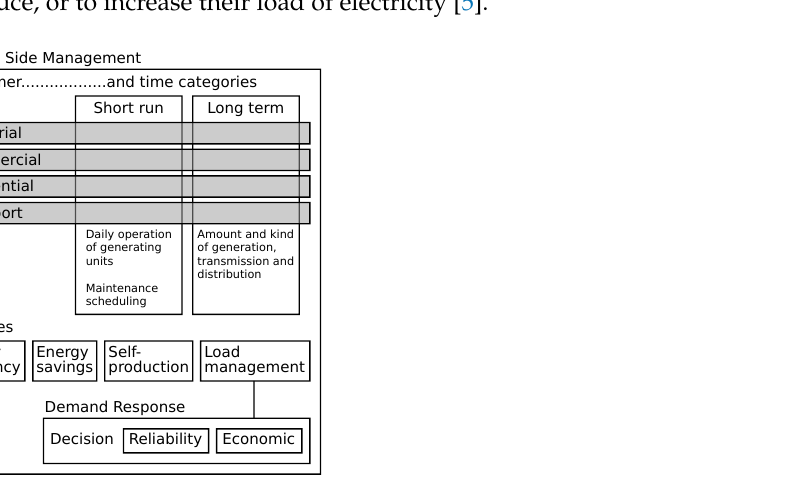
Figure 2. Demand side management categories: Demand response as an element; based on